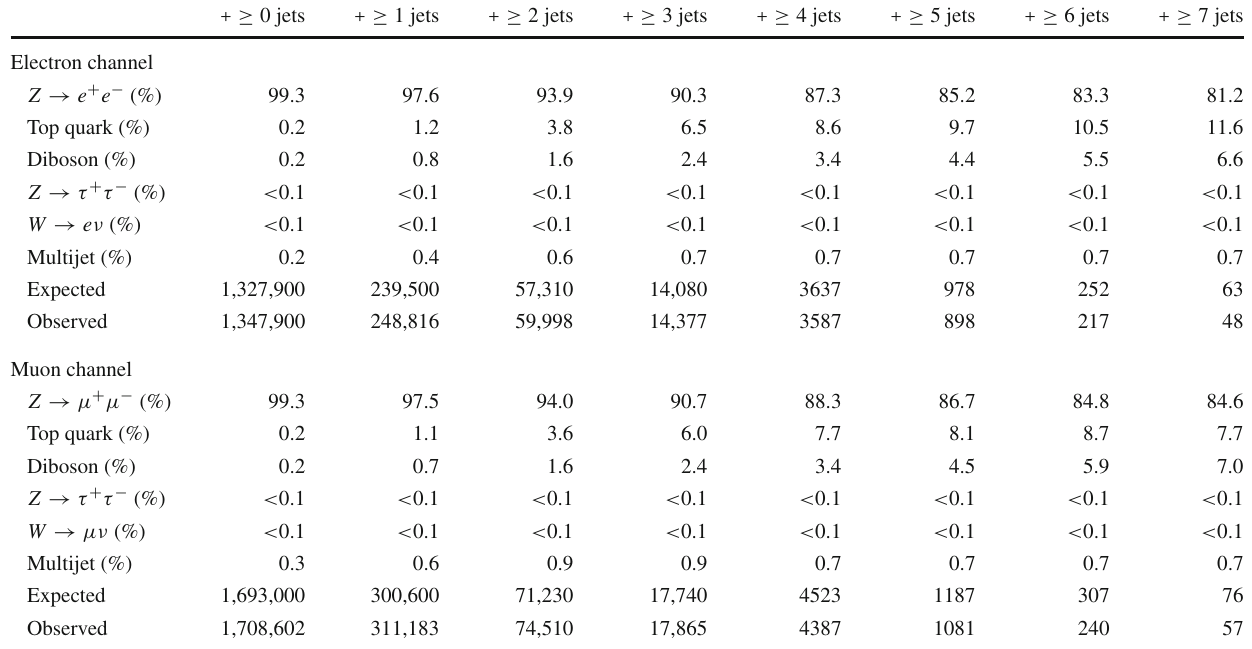
Table 2 Fraction of signal and background processes in % in the final selection and expected and observed numbers of events for the various inclusive jet multiplicities considered in the electron (top) and muon (bottom) channels + ≥ 0 jets + ≥ 1